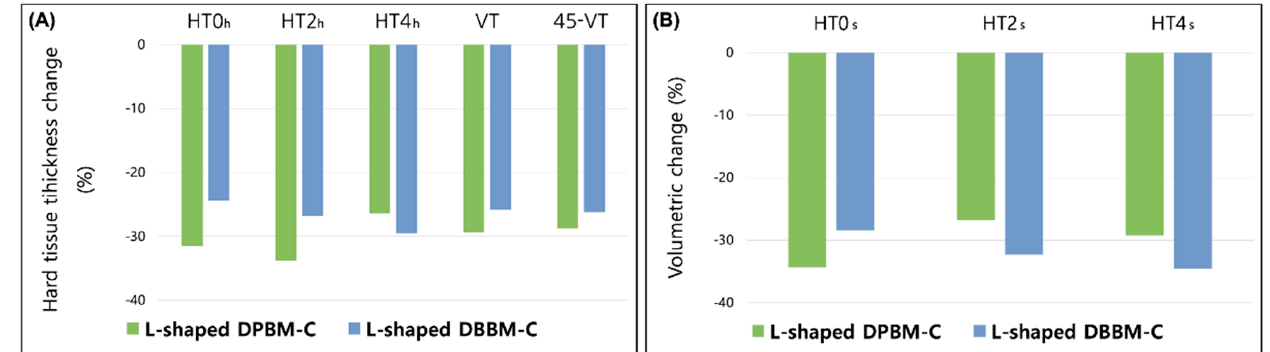
Figure 4. Comparison of radiographic and volumetric outcomes of the L-shaped DPBM-C and DBBM-C groups. ( A ) Horizontal and vertical changes in the mean percentage of hard tissue thickness during the healing period (T1 and T2) measured at HT0h, HT2h, HT4h, VT, and 45-VT. ( B ) Horizontal changes in the mean percentage of soft tissue thickness during T1 and T2 were measured at HT0s, HT2s, and HT4s. No significant differences between the compared two groups were found ( p > 0.05).